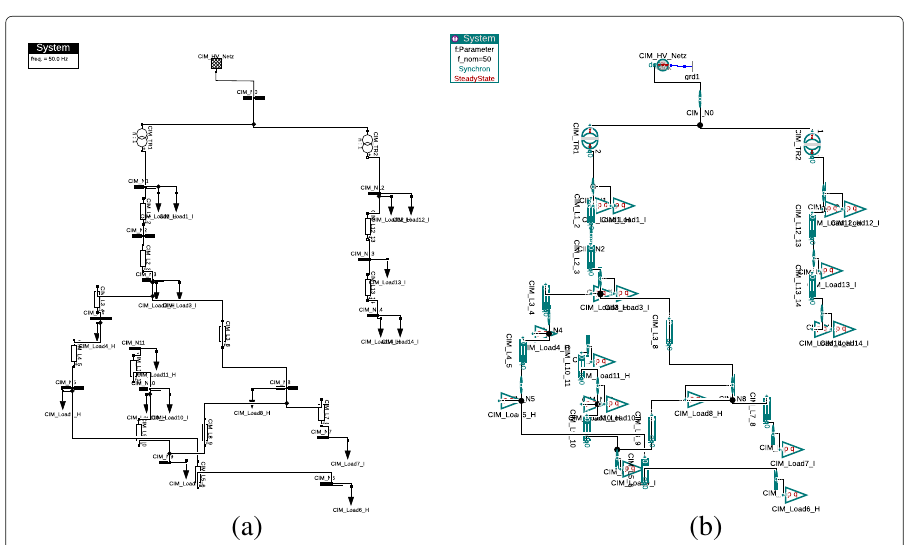
different Modelica Libraries is presented. Actually, the approach handles SimModel doc- uments which are a kind of BIMs and based on pure XML (without RDF) which allows the direct use of an XML data binding framework for XML data unmarshalling. The mapping rules are specified in an XML format and the Modelica code generation is hard coded in Python scripts.